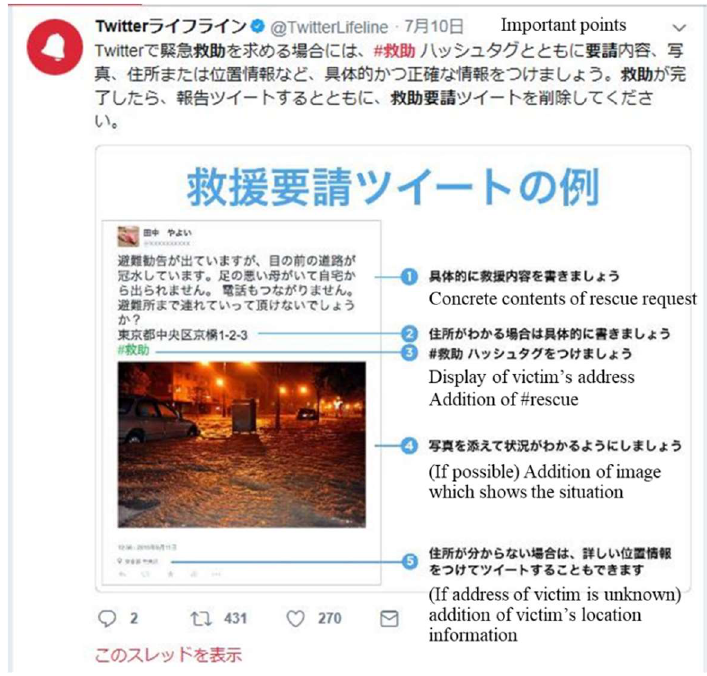
Fig. 7. Example tweet of rescue request using Twitter proposed by the Twitter Japan.